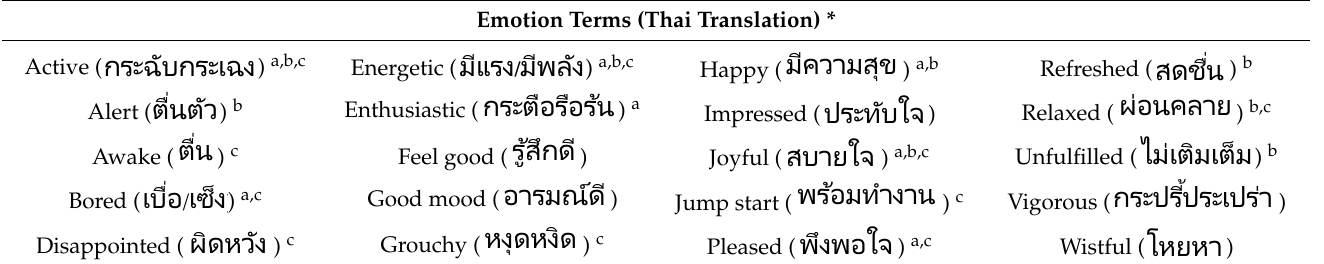
Table 2. A list of 20 emotion terms with Thai translation evaluated in the study.